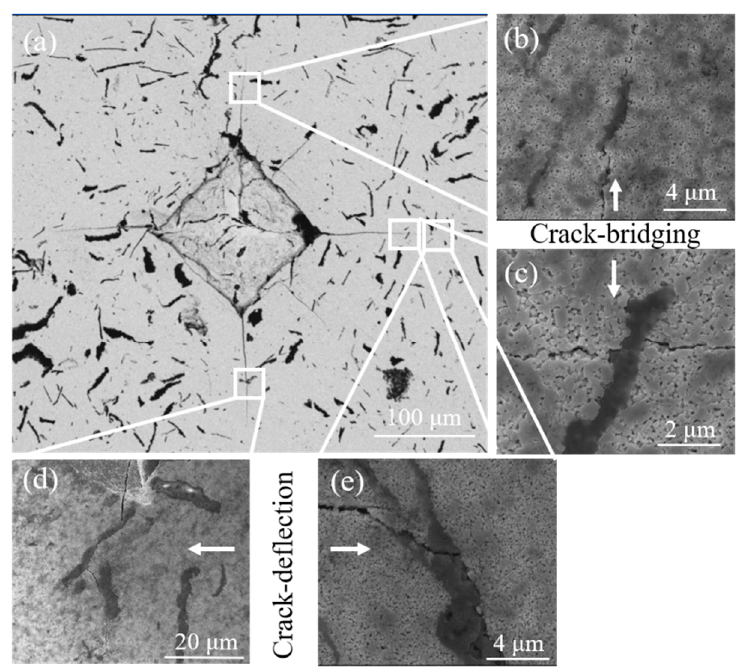
Figure 10. SEM images of indentation cracks observed in the sintered WC-10Ni 3 Al composites using CH 3 CH 2 OH. ( a ) Vickers indentation; ( b , c ) crack-bridging; ( d , e ) crack-deflection.